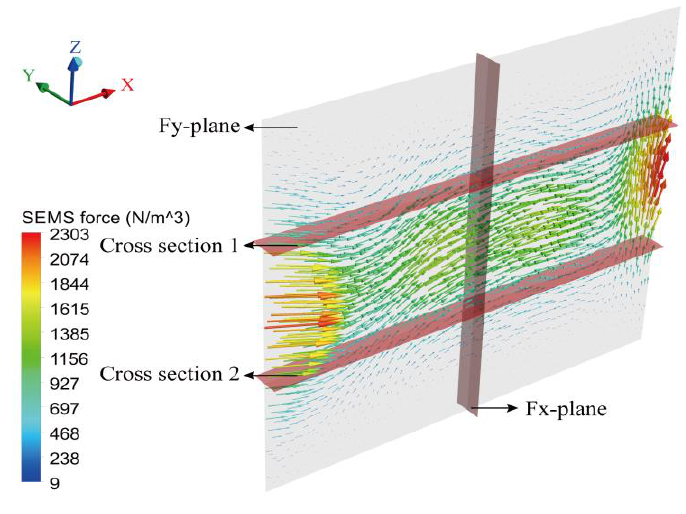
Figure 7. Time-averaged electromagnetic stirring force in the middle section of the wide face. A strand 1.1 m long in the casting direction was chosen.